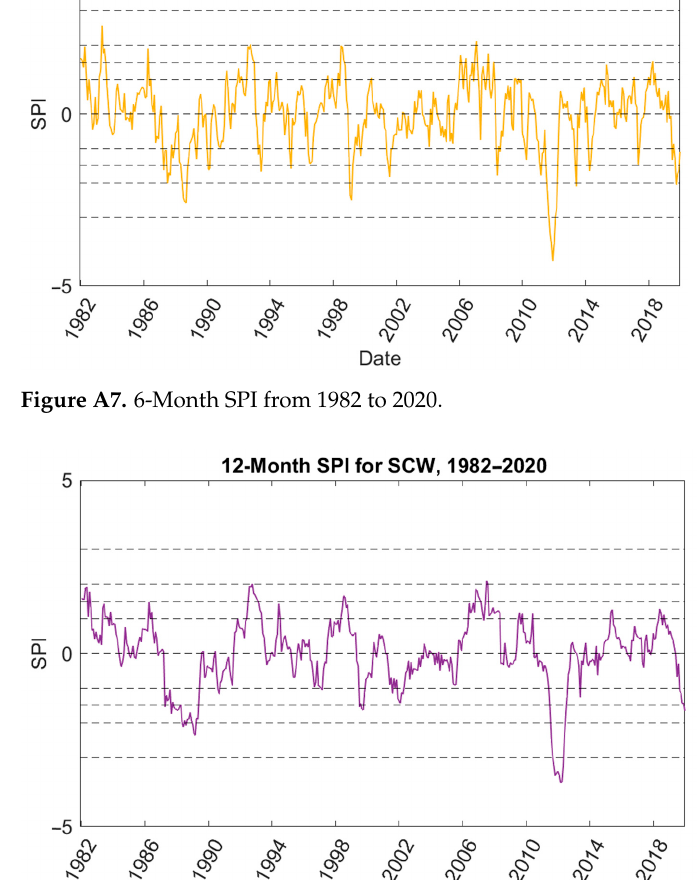
Figure A8. 12 ‐ Month SPI from 1982 to 2020.